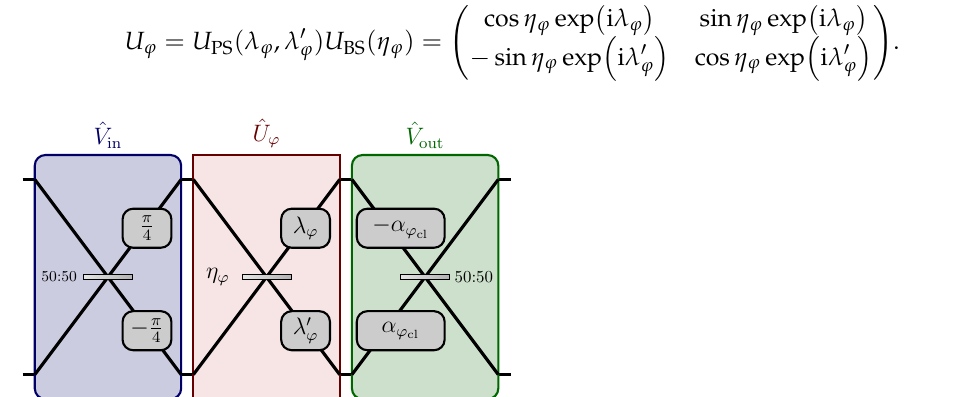
Figure 4. Schematic diagram of the two-channel network described in Section 2.4. The linear network ˆ U ϕ is composed of a beam splitter with coefficient η ϕ and two phase-shifts of magnitudes λ ϕ and λ (cid:48) ϕ . The auxiliary stage ˆ V in at the input is ϕ -independent, while the output stage ˆ V out is optimized after a classical prior estimation ϕ cl of the parameter. In particular, the quantity α ϕ depends on ϕ cl only through the phase-shifts λ ϕ